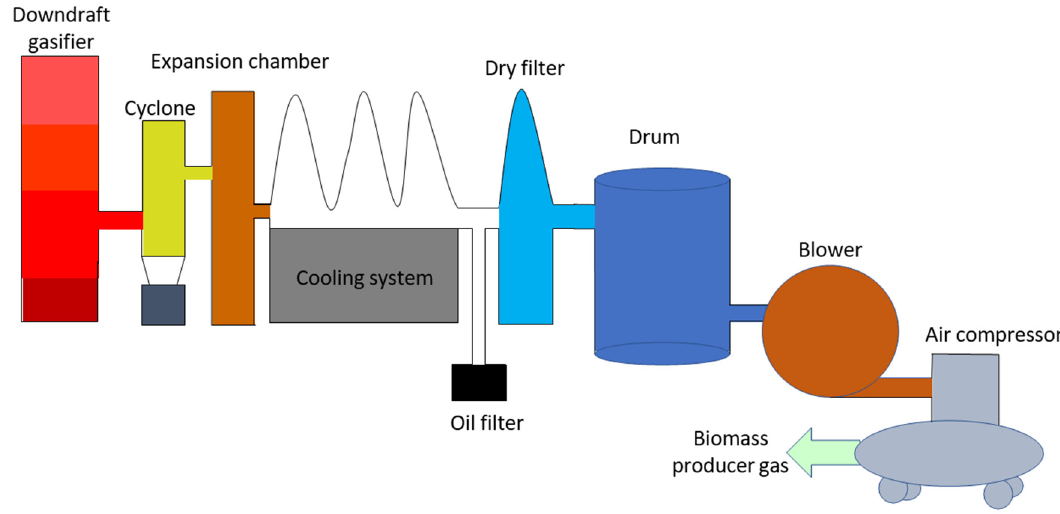
Figure 3. Scheme diagram of gasification.